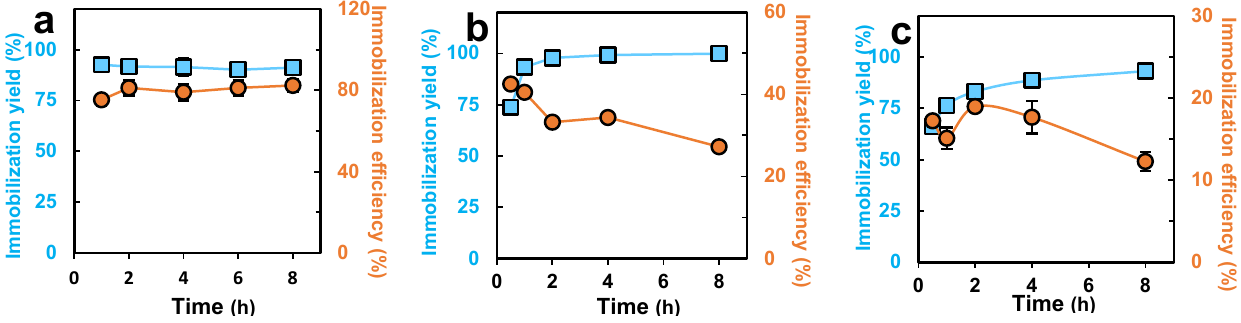
Figure 3. The effect of the immobilization time on the immobilization of enzymes (blue rectangle: immobilization yield, yellow sphere: immobilization efficiency, ( a ) FLS, ( b ) ADH, ( c ) NOX).